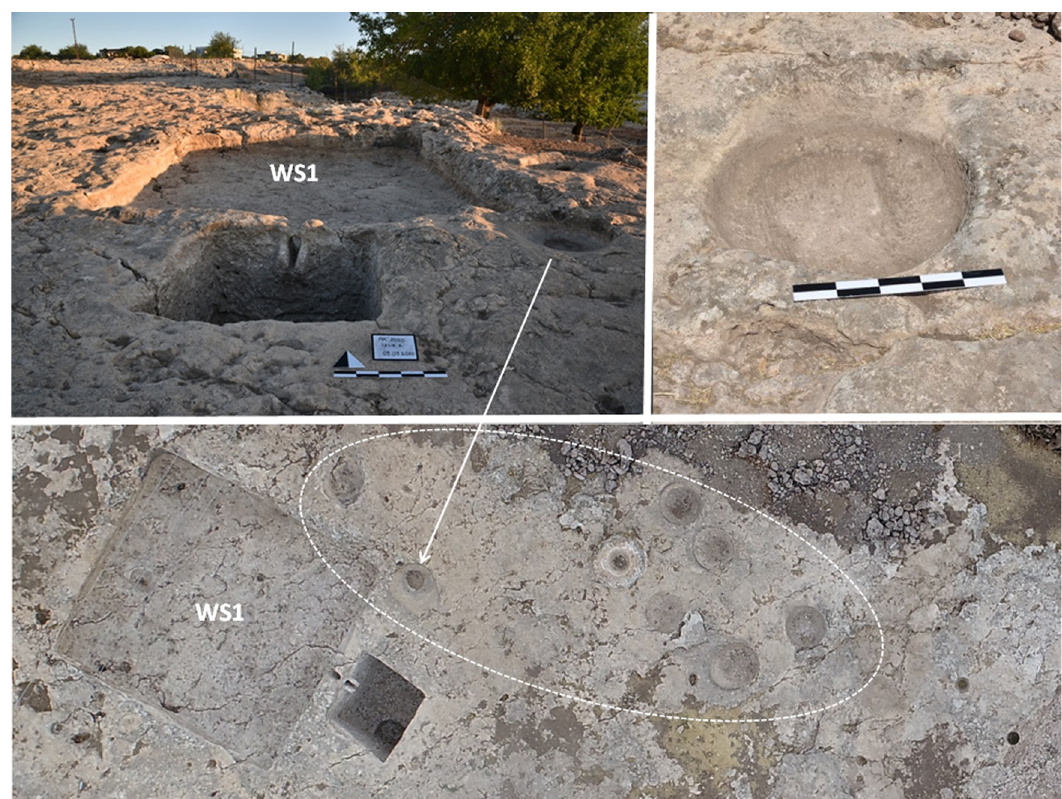
Figure 9: Area of shallow pits ( circled white ) next to WS1 ( Ambarçay Salvage Excavation Archive )